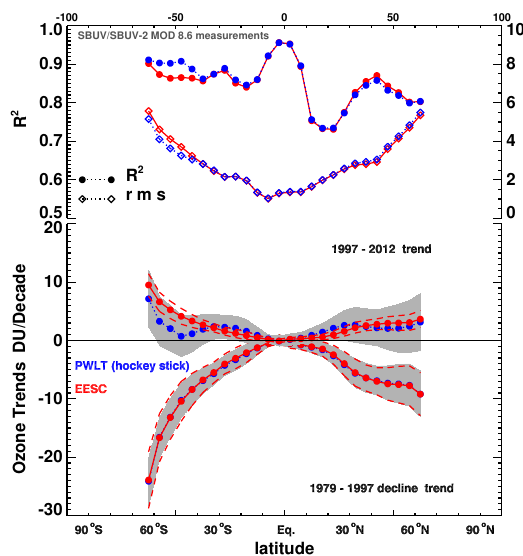
Figure 6. (top panel) Zonal distribution of R 2 and rms estimated for the 1979–2012 SBUV/SBUV-2 V8.6 merged data set from re- gression model based on Eq. (1) in red and the piecewise linear trend (PWLT or hockey stick) model in blue. (bottom panel) Zonal distribution of the linear trend of ozone in DUdecade − 1 units cal- culated for the declining part of EESC during 1979–1997 and for the increasing part of EESC during 1997–2012 (red) as well as the trends before and after the ODS turnaround (1997) calculated by the PWLT model (blue). The statistical significance at two sigma level is indicated as grey shades for PWLT and dashed lines for